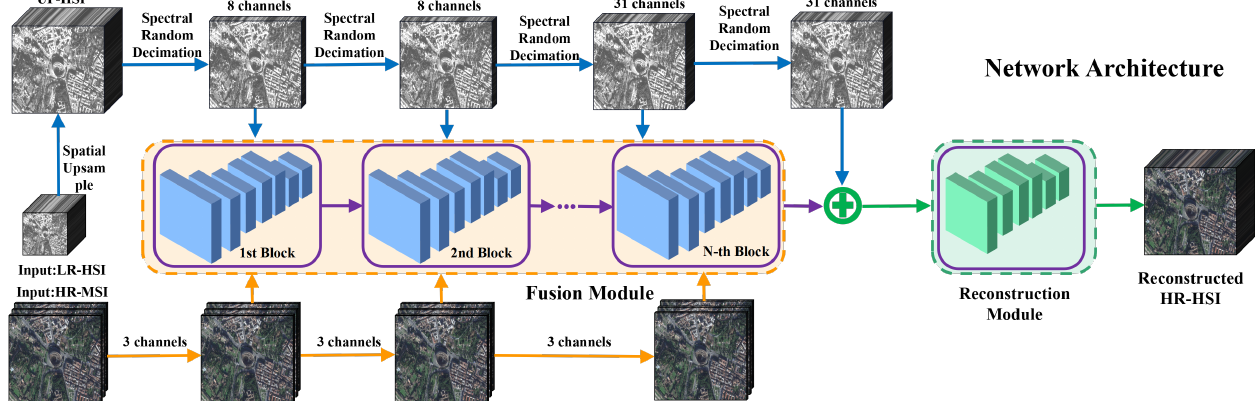
Figure 3. The overall flowchart of the proposed MINet for multispectral and hyperspectral image